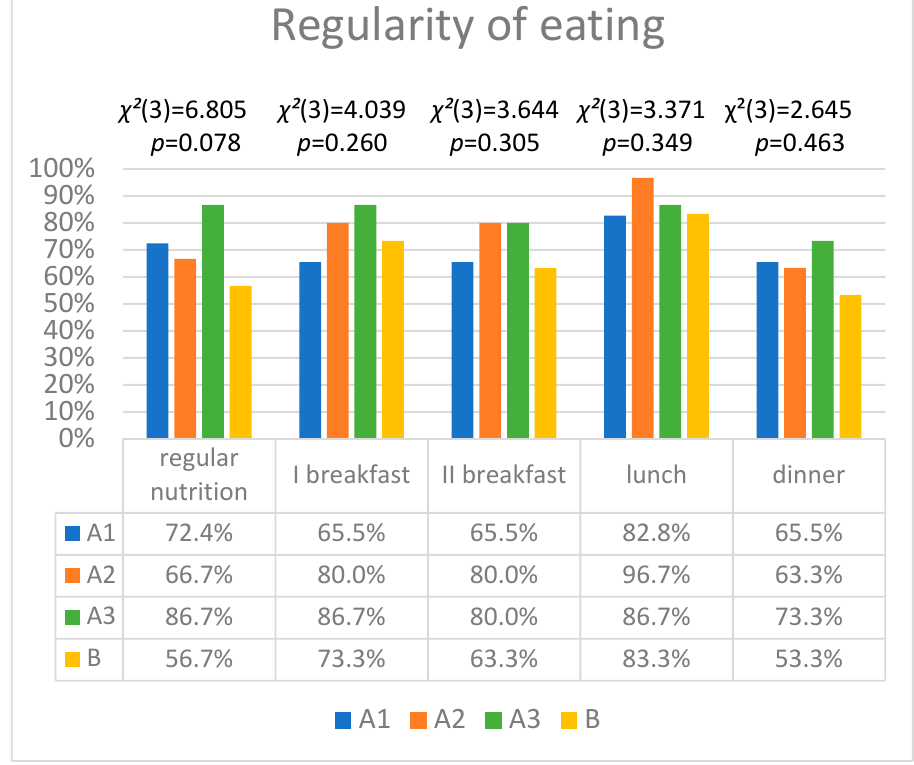
Figure 1. The regularity of eating and of having meals regularly for girls from the sports groups (A1, A2, A3) and from the control group (B). χ 2 —test result; degrees of freedom—df provided in brackets; p —statistical significance.